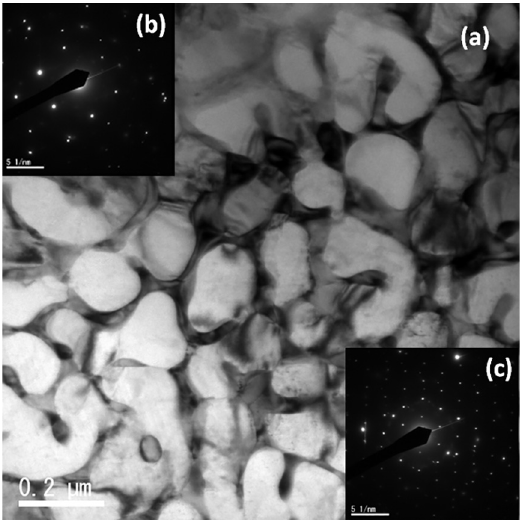
Figure 2: (a) Bright-field and (b) (c) selected area electron diffraction patterns in different phases of the Fe All the present as-spun alloy ribbons are ductile,